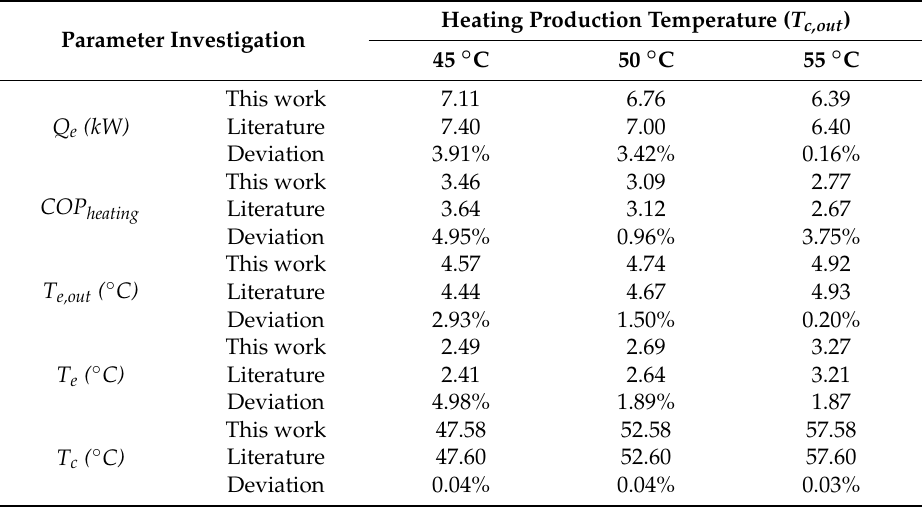
Table 3. Comparison of the developed model with the literature results